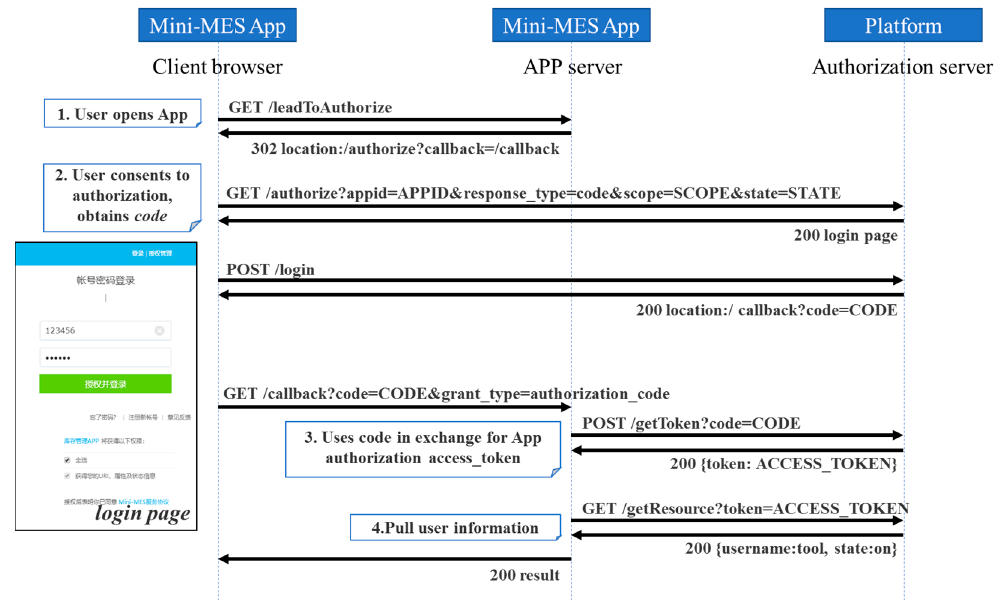
Figure 5. App authorization supported by OAuth2.0.